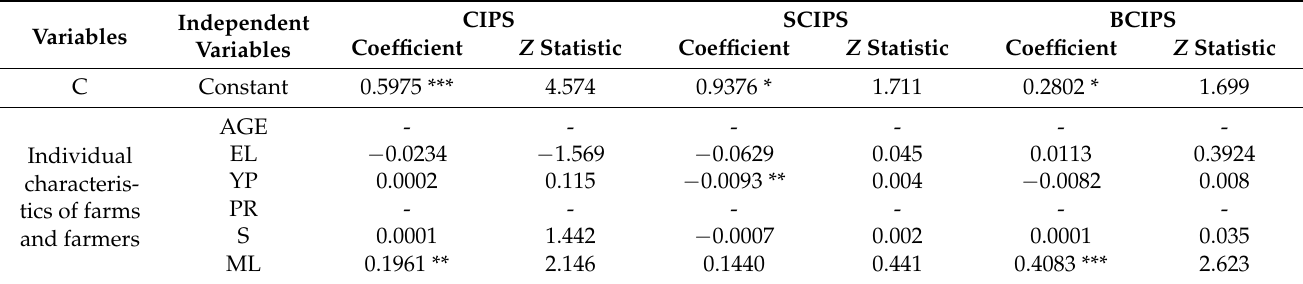
Table A3. Test Results (1) of the Data Fit Analysis of the Tobit